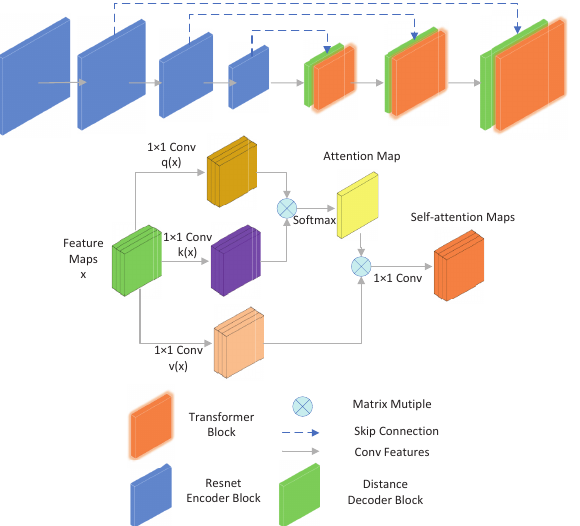
Figure 6. This is our depth network architecture; we use a self-attention decoder to obtain better depth